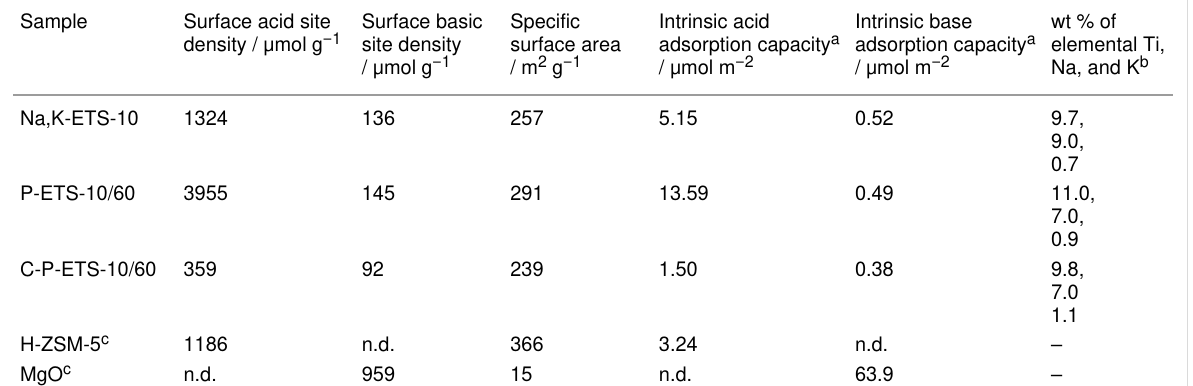
Table 2: NH 3 TPD, CO 2 TPD, and ICP OES data for Na,K-ETS-10, P-ETS-10/60, and C-P-ETS-10/60. n.d. – no data. Sample